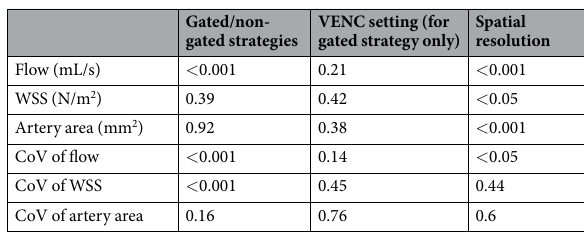
VENC setting (for gated strategy only)